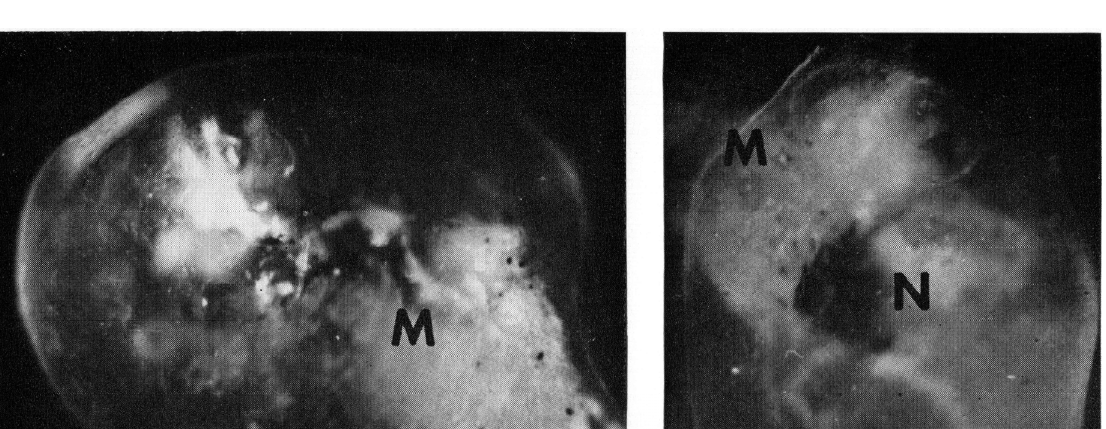
Figure 2. Two examples of “Frankensteinian” preparations prepared and filmed in 1961 at the Hubrecht International Embryology Laboratory in Utrecht, The Netherlands, consisting of anuran neural plate tissue, plus mesoderm, encased in a transparent ball of ectoderm. Differentiated CNS fragments (N) are covered by a pigment layer, and twitches of the muscle fibers (M) could be easily followed through a stereo microscope.